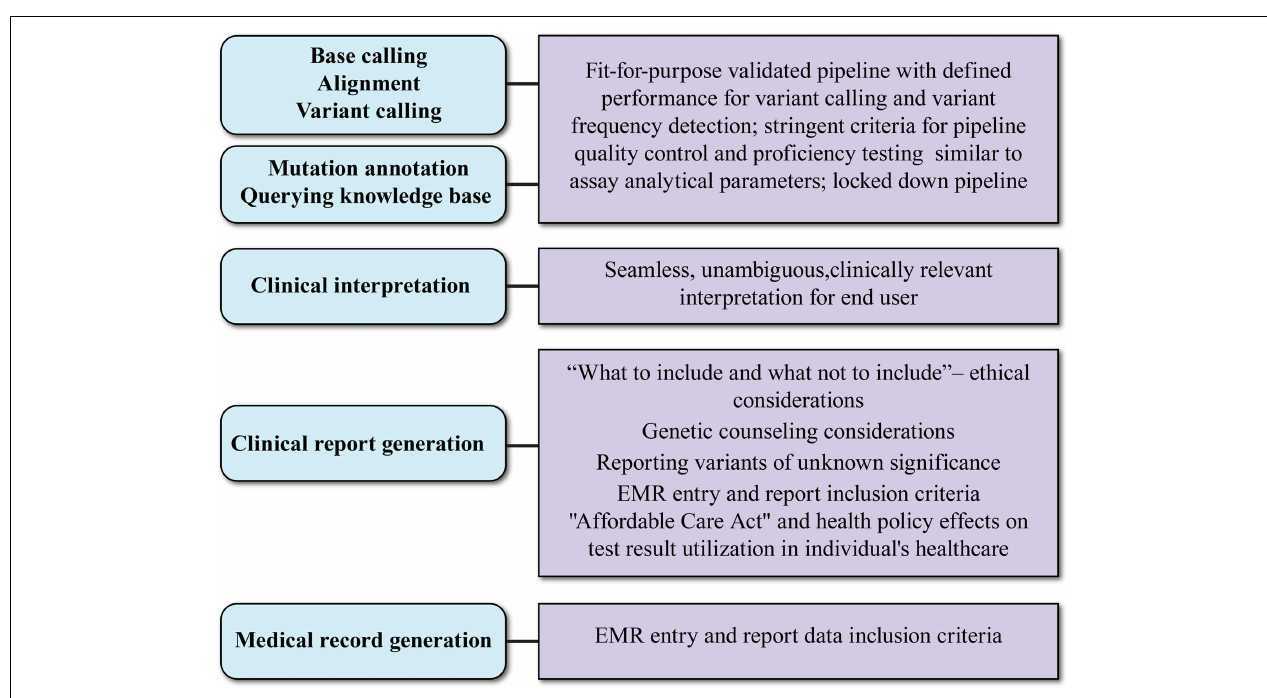
the clinical report (fourth oval) is influenced by socio-ethical considerations and may require genetic counseling and support systems.The evolving payer landscape and medical records guidance will affect how NGS clinical reports are captured in patient